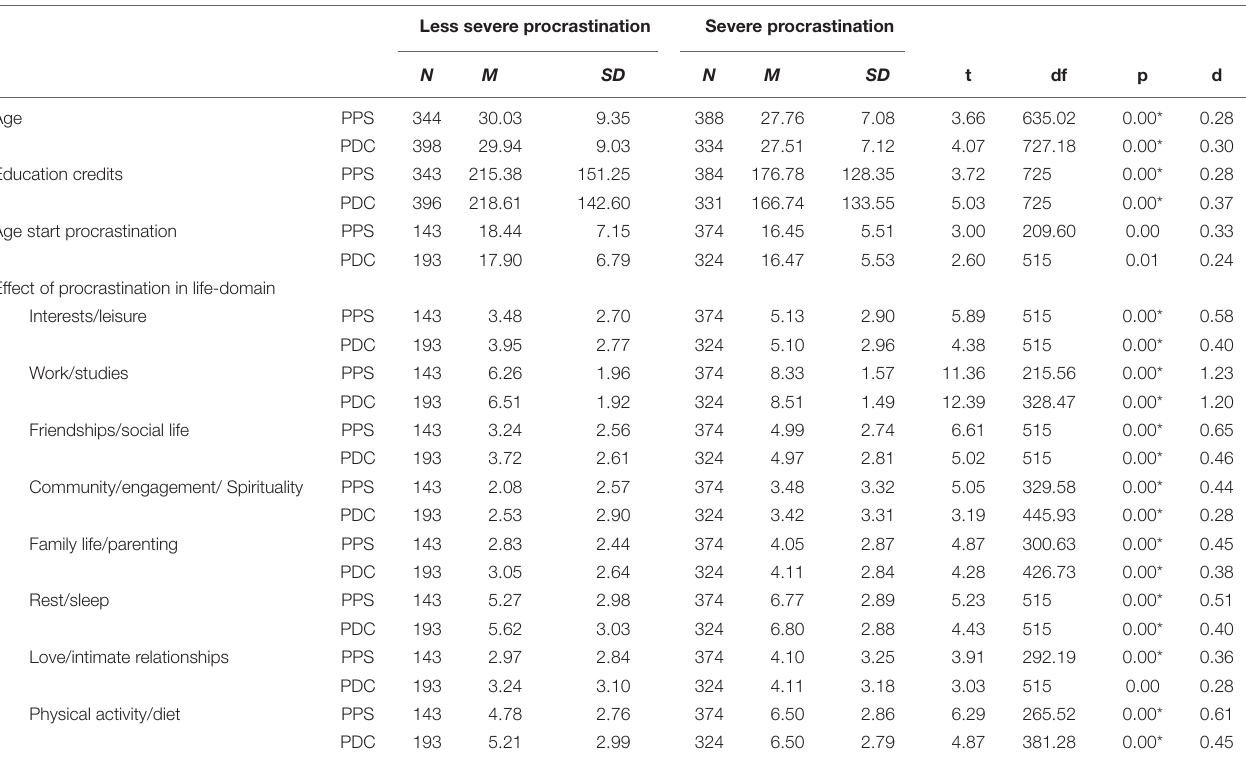
TABLE 3 | Differentiating severe procrastination from less severe procrastination. Less severe procrastination Severe